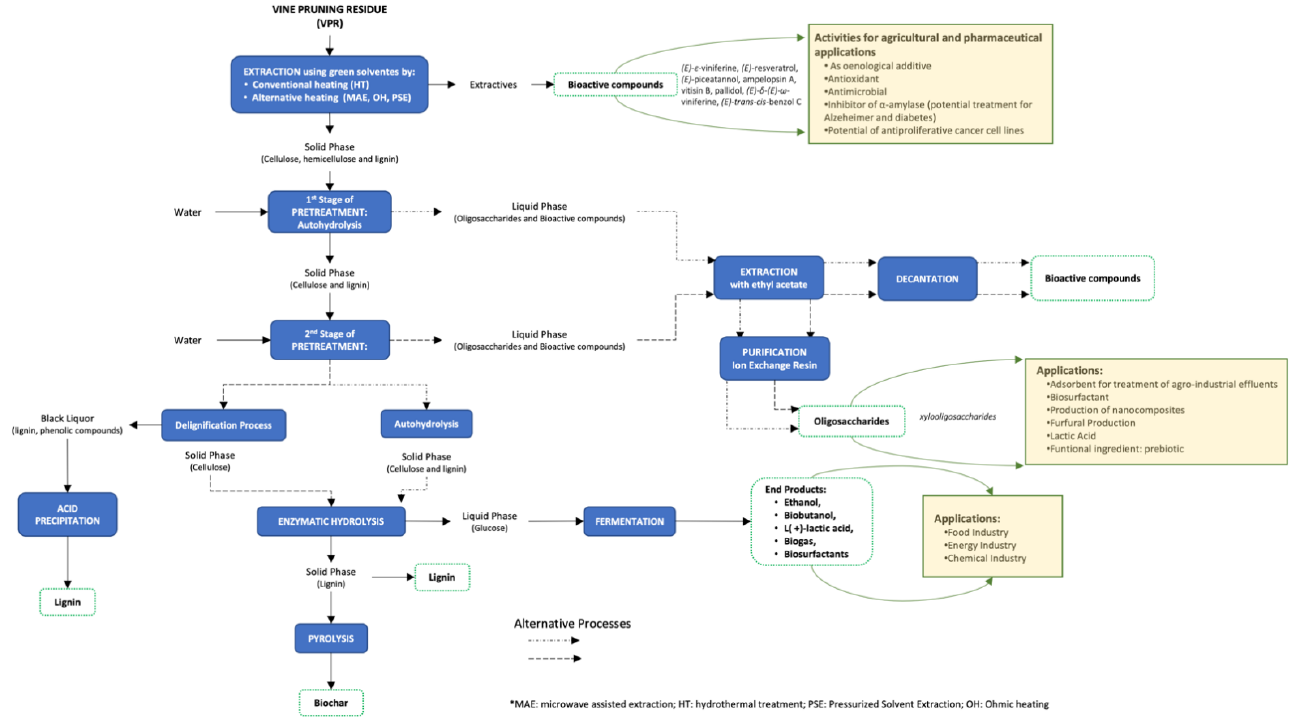
Figure 3. Proposal of a biorefinery scheme for the integral valorisation of vine-pruning residues and the potential applications of the main components.